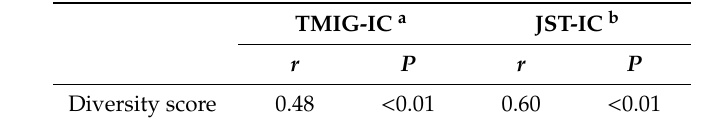
Table 3. Correlation coe ffi cient between external standards and the diversity